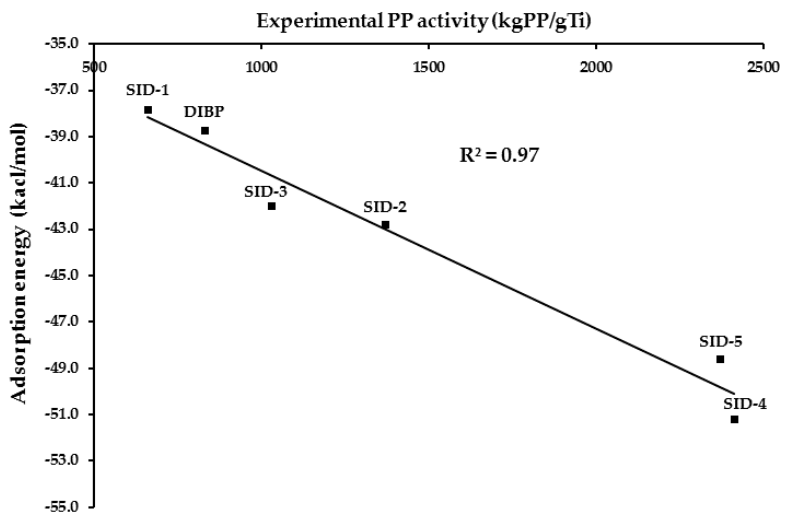
Figure 4. Relationship between the calculated adsorption energy and the experimental polypropylene (PP) activity of five salicylate (SID) and diisobutyl phthalate (DIBP) donors.